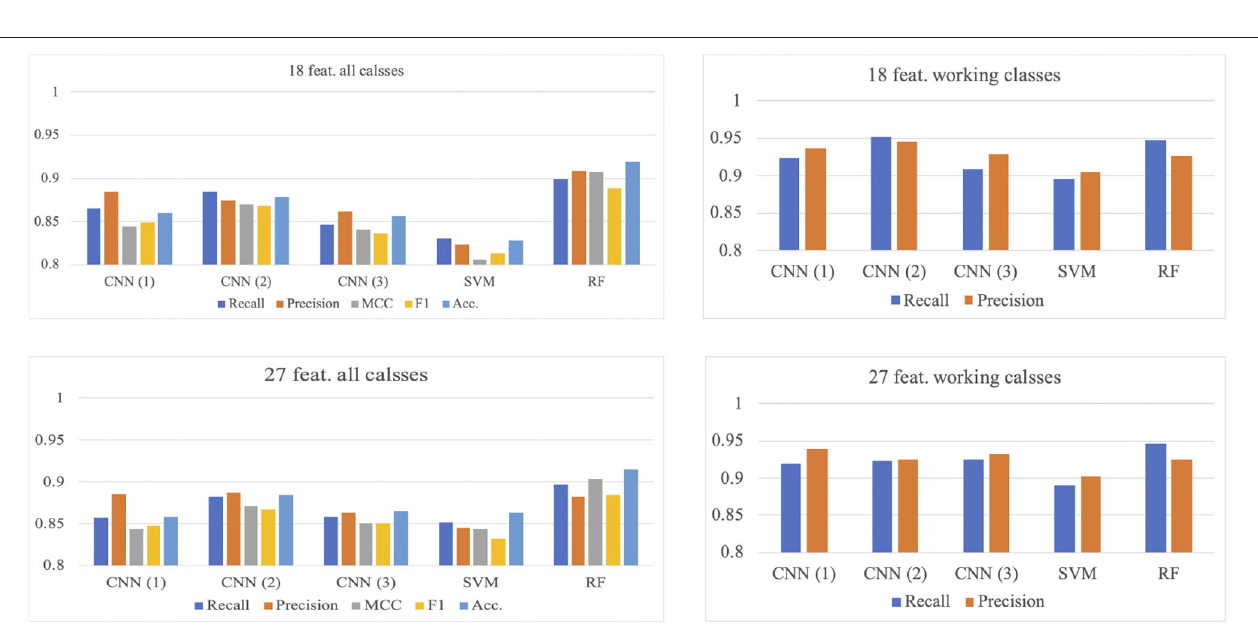
FIGURE 6 | Models comparison of LOO validation. CNN(1), CNN(2), and CNN(3) corresponds to the model with 1, 2, and 3 convolutional layer(s),